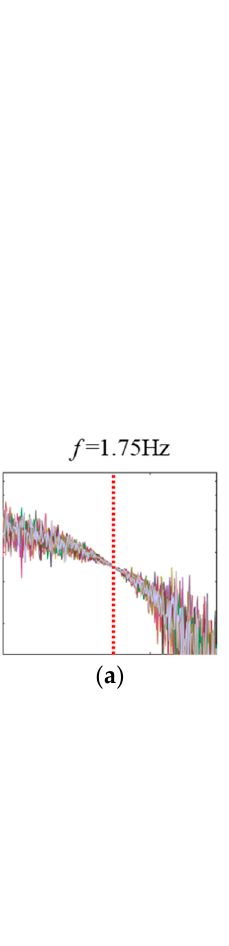
Figure 6. TRFs near each characteristic frequency. ( a ) Natural frequency 1; ( b ) natural frequency 2; ( c ) natural frequency 3; ( d ) natural frequency 4; ( e ) excitation frequency 1; ( f ) excitation frequency 2.